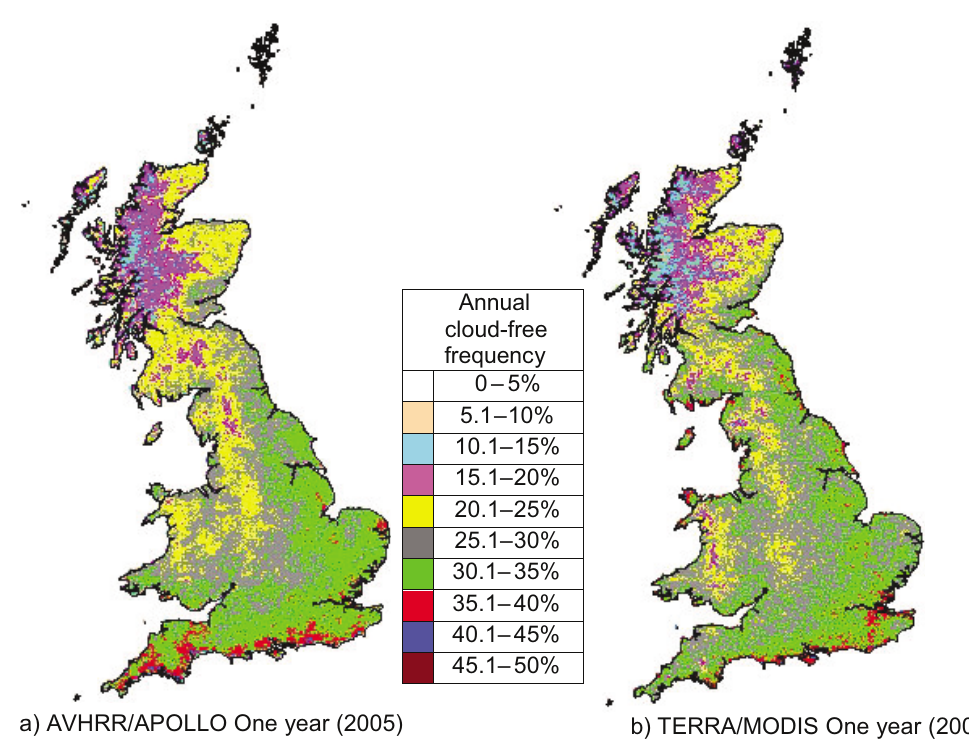
Fig. 3. Classification of (a) AVHRR/APOLLO and (b) TERRA/MODIS one year image of cloud-free areas in the UK